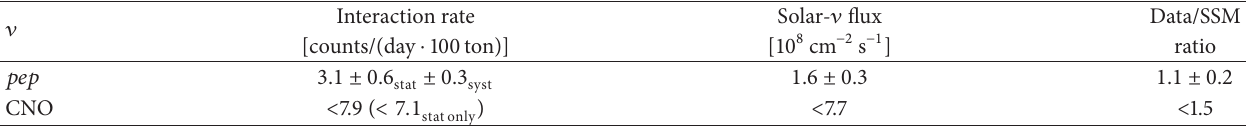
Table 6: Best estimates for the 𝑝𝑒𝑝 and CNO solar neutrino interaction rates. For the results in the last two columns both statistical and systematic uncertainties are considered. Total fluxes have been obtained assuming MSW-LMA and using the scattering cross-sections from [146, 148, 149] and a scintillator 𝑒 − density of (3.307 ± 0.003) ⋅ 10 29 ton − 1 . The last column gives the ratio between our measurement and the high-Z (GS98) SSM [64]. Table taken from [74].